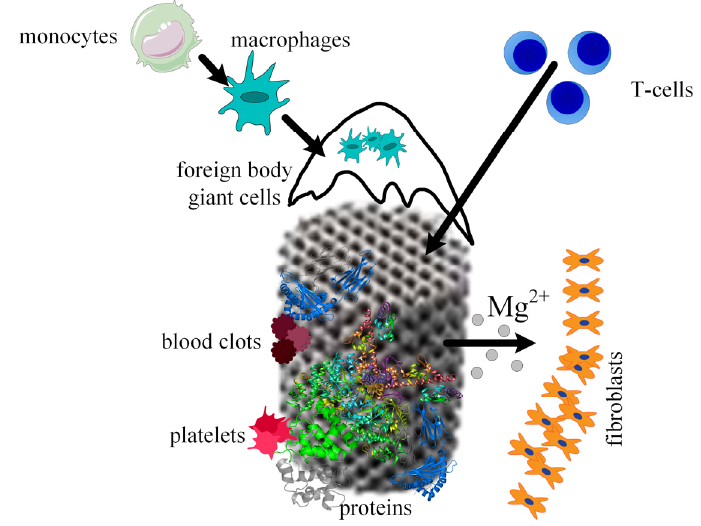
Figure 9. Osseointegration process of the scaffold. Firstly, proteins adhere to the scaffold material, then platelets begin the blood clotting formation, immune system cells migrate to the wounded tissues due to the inflammation process, Mg 2+ ions diffuse away as a consequence of the metal corrosion, and fibrous tissue encapsulation appears.